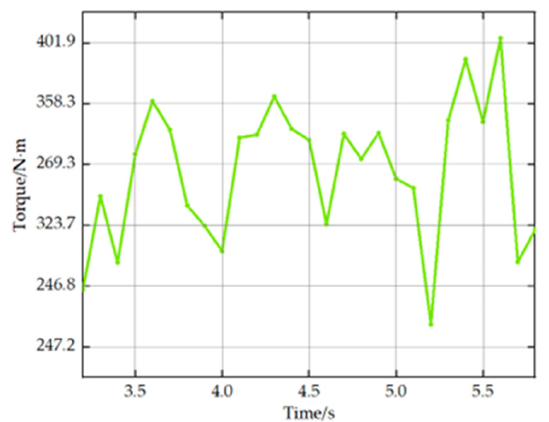
Figure 11. Rotary tiller operating torque versus time variation .